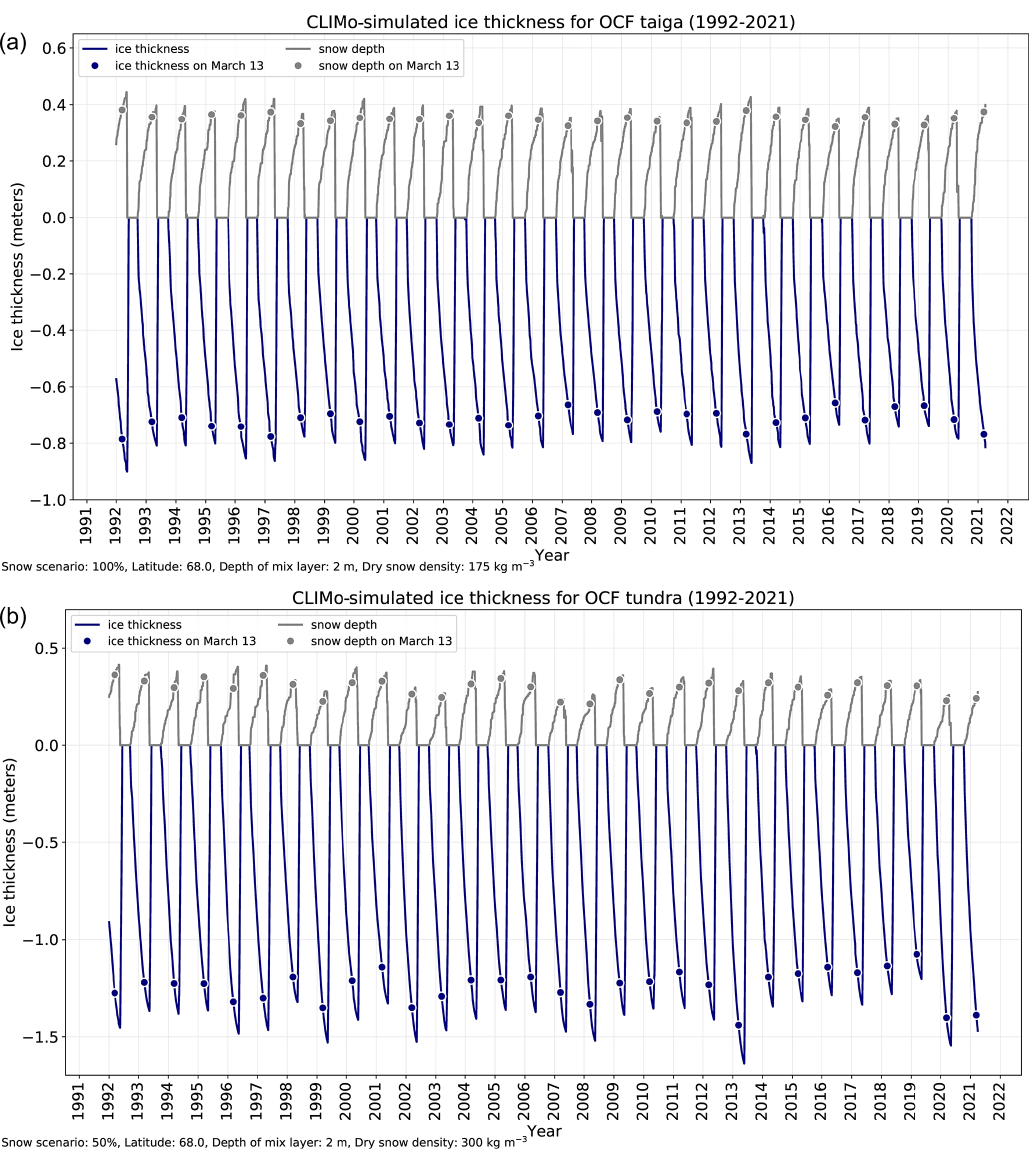
Figure 9. CLIMo-simulated ice thickness for the OCF: (a) simulation for the taiga environment; (b) simulation for the tundra environment. Dark blue represents ice thickness and grey stands for snow depth. The grey and dark blue points mark the condition on 13 March (the last day of the time series) for each